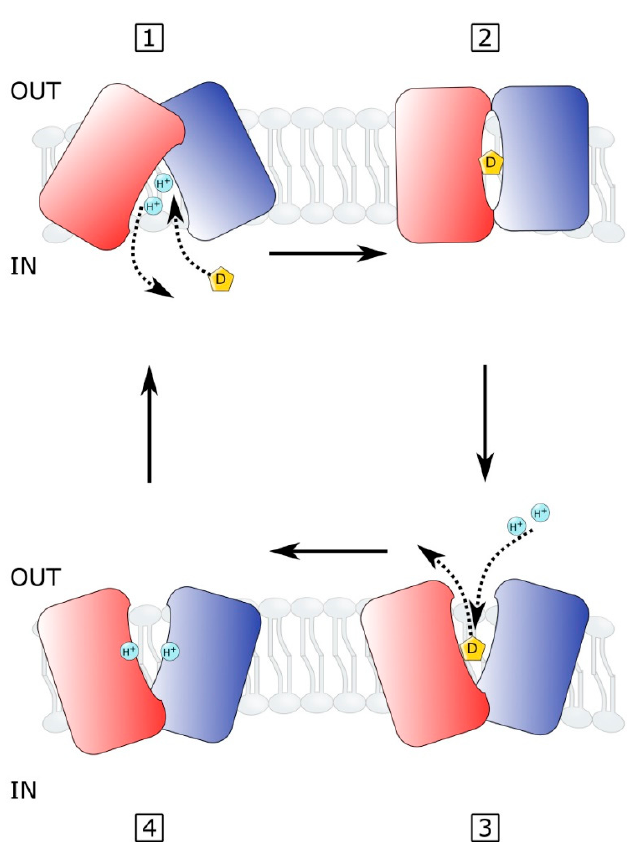
Figure 3. A rocker-switch mechanism was proposed for MFS transporters. In this proposed antiport system, proton-driven drug efflux occurs through the pump by alternately exposing the drug (D) binding site to either side of the membrane. The drug translocation process involves conformation changes in the two bundles or halves of the MFS pump to form inward open, occluded, and outward-facing open conformations (steps 1-4 in the Figure) [118,119].